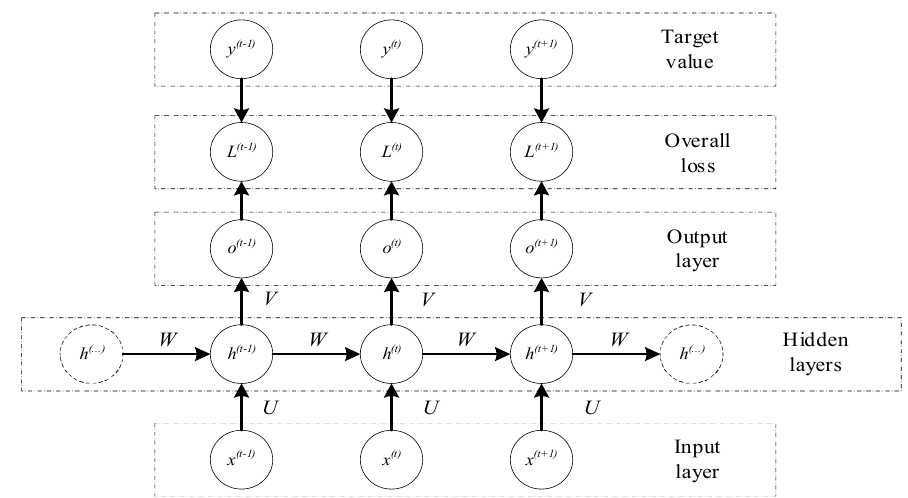
Figure 3. RNN network structure diagram.